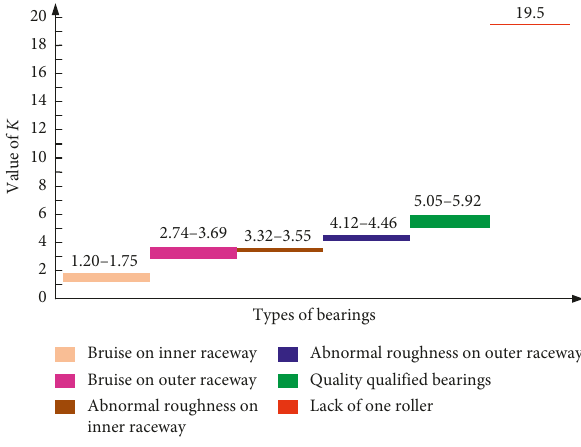
Figure 17: Chart of the actual